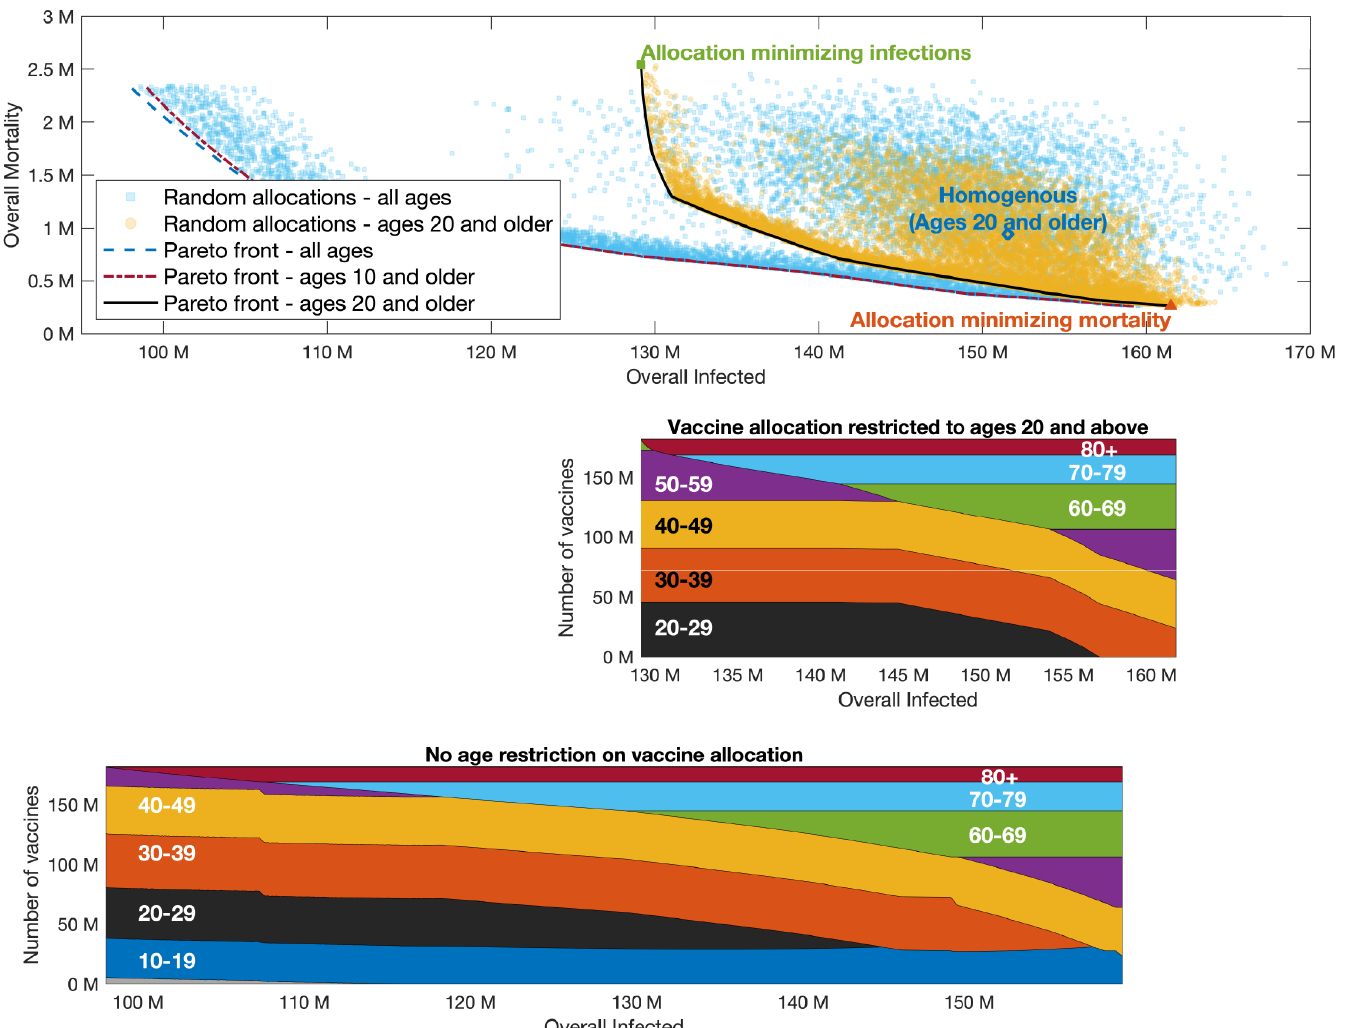
Fig 5. Pareto front. R 0 = 4. Top graph presented outcomes of random allocations when all ages are eligible for vaccination (square blue markers) and only ages 20 and older are eligible (round yellow markers). Super-imposed are the Pareto fronts in the case ages 20 and older are eligible for vaccination (black solid), ages 10 and older are eligible (yellow dash-dotted) and when all ages are eligible (purple dashed). The latter two curves are indistinguishable. Bottom graphs present vaccine allocation along the Pareto fronts in the case of ages 20 and older are eligible for vaccination, and when all ages or ages 10 and older are eligible for vaccination.